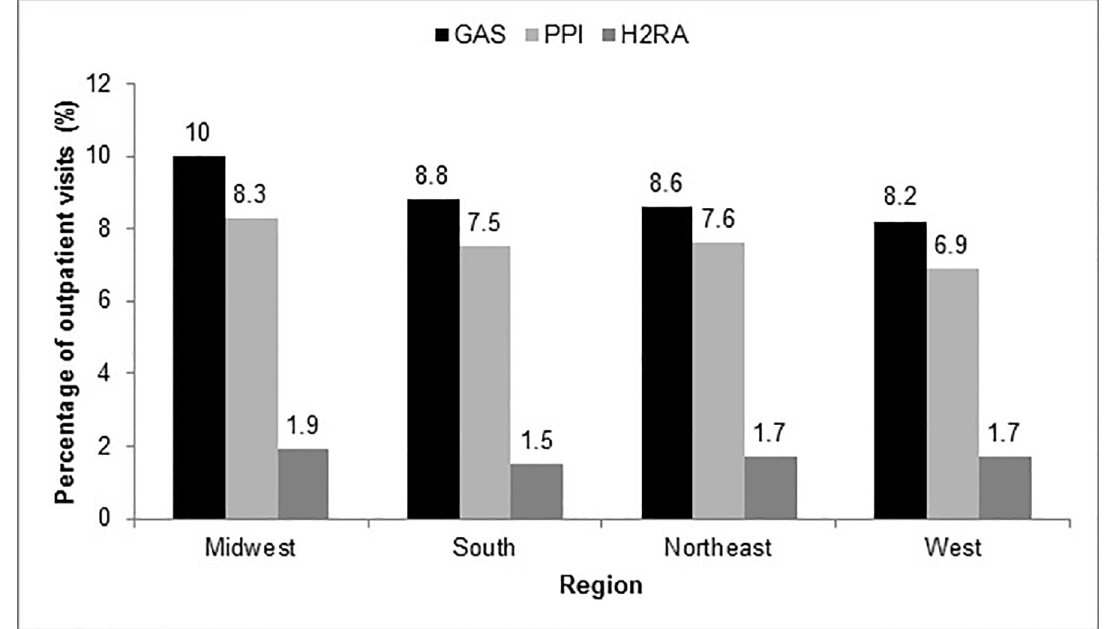
Fig 2. Regional GAS prescribing trends. GAS: gastric acid suppressant; H2RA: histamine-2 receptor antagonist; PPI: proton pump inhibitor.